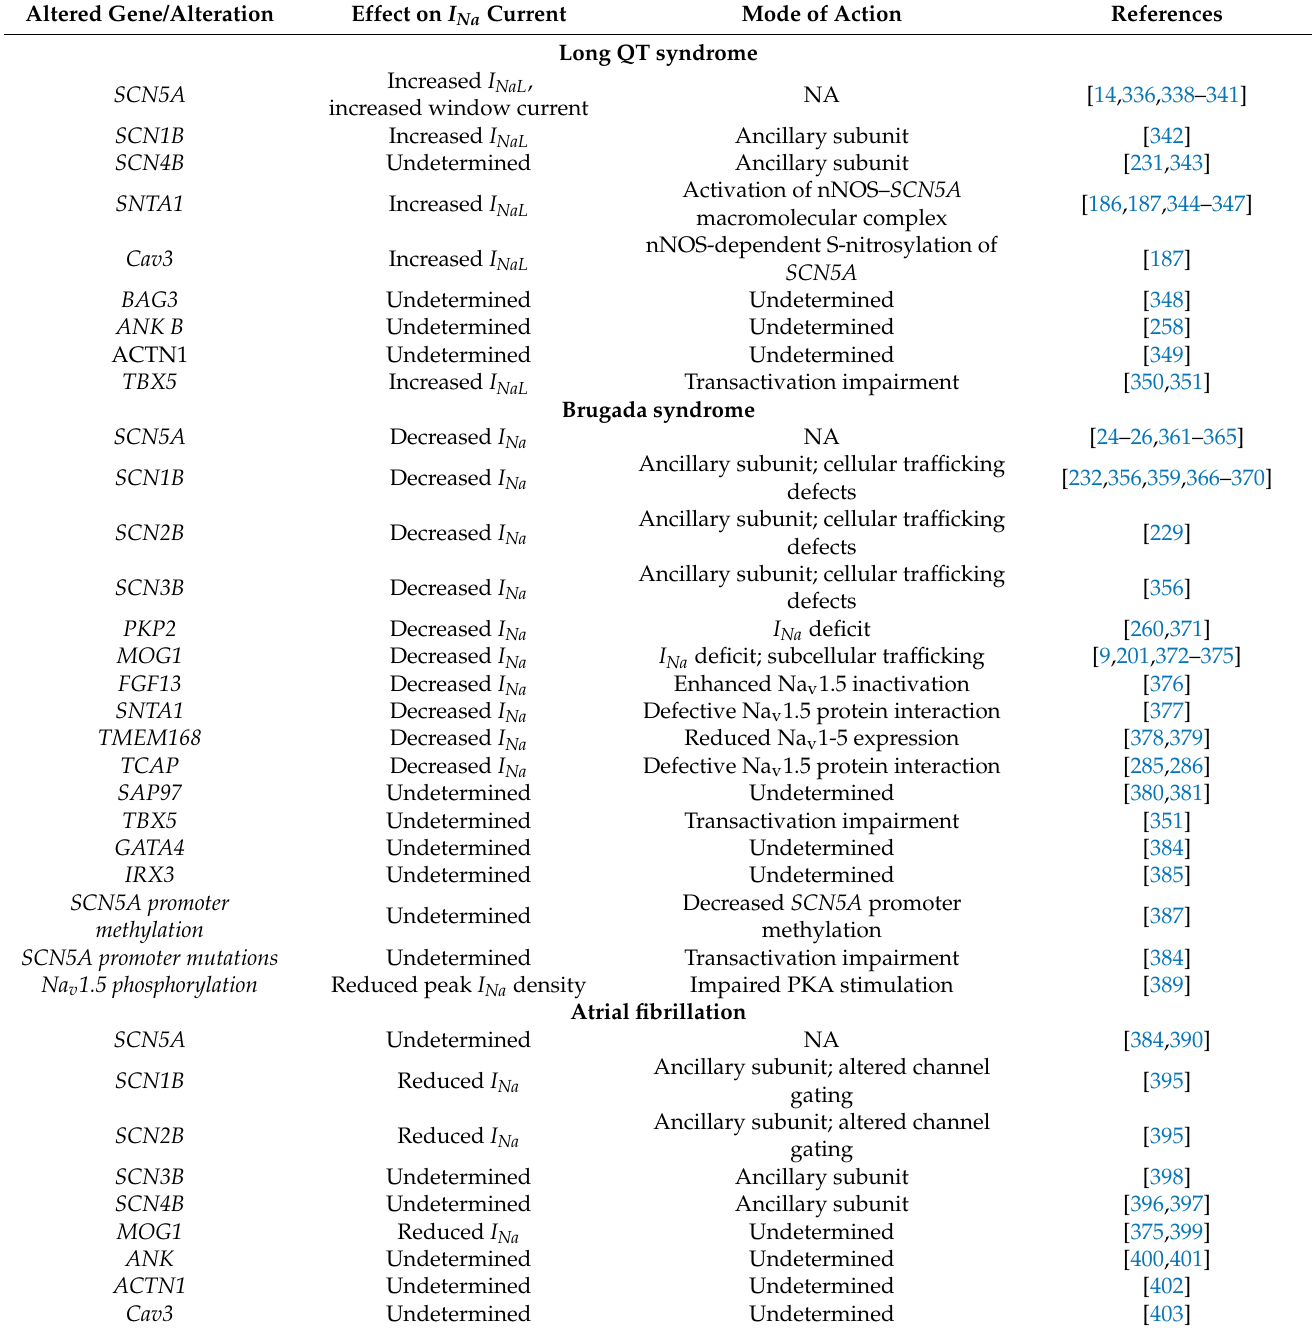
Table 1. Summary of the Na v 1.5-interacting protein-coding genes involved in cardiac sodium